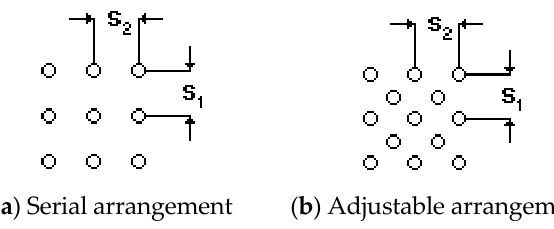
Figure 2. Tube arrangement in exhaust gas boiler where: s 1 (m) is the vertical gap between the tubes; s 2 (m) is the horizontal gap between the tubes.